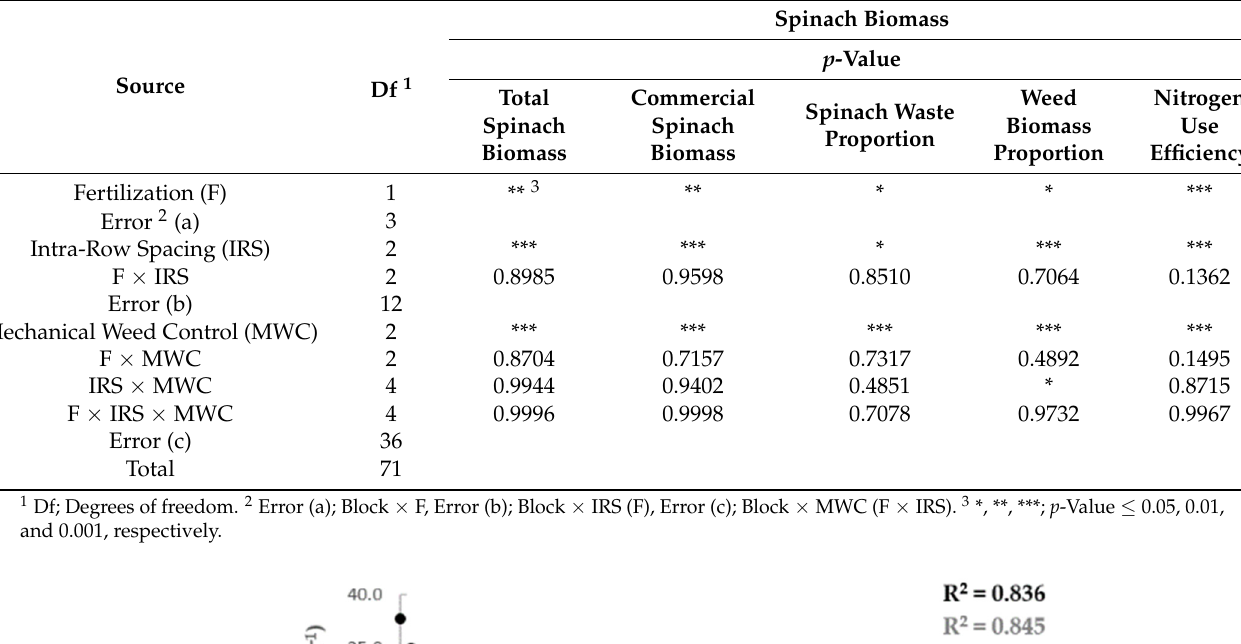
Table 4. The effects of fertilization, intra-row spacing, and mechanical weed control on total spinach biomass, commercial spinach biomass, spinach waste proportion, weed biomass proportion, and nitrogen use efficiency. For each parameter, p -Values of are presented as derived from three-factor Analysis of Variance (ANOVA) performed ( a = 0.05).